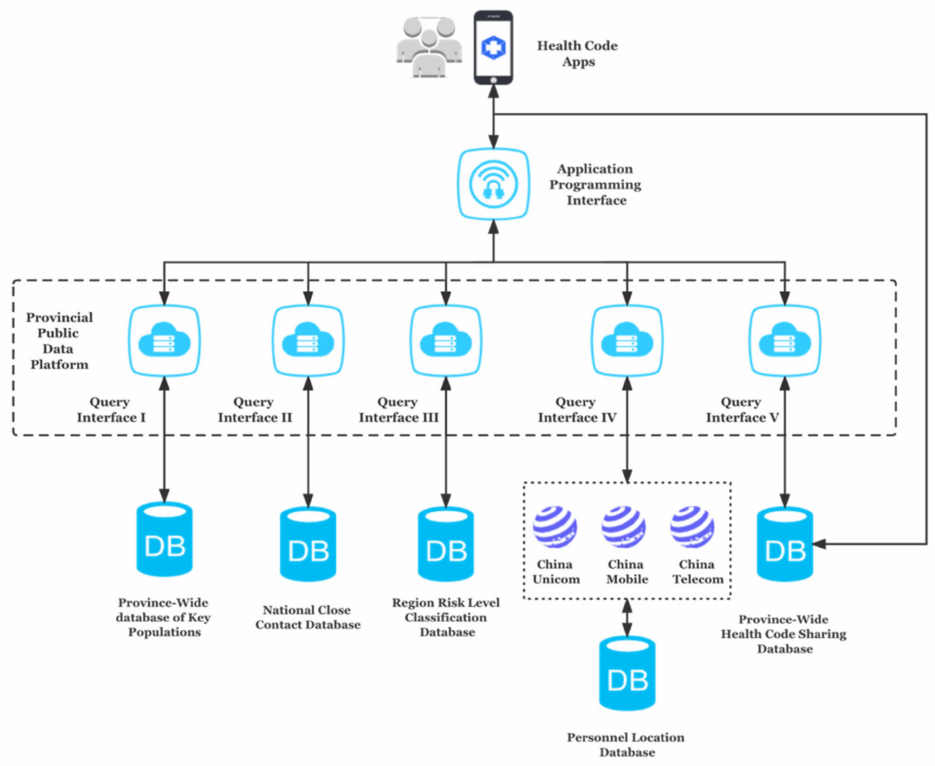
Figure 3. Hangzhou Health Code operation